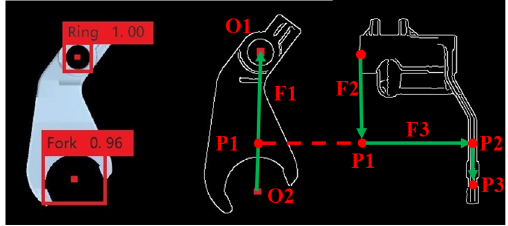
Figure 7. The mesh solid model and the detection sequence of the shifting fork.